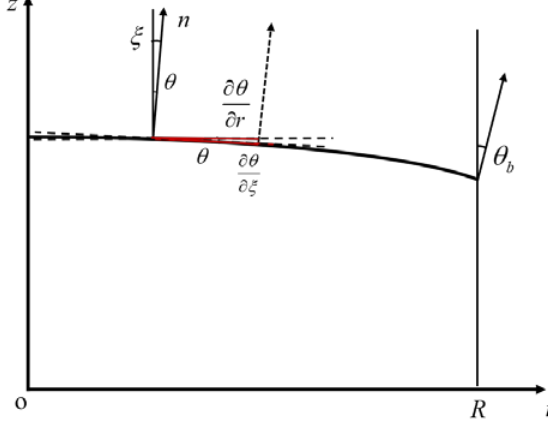
Figure 5. Schematic diagram of detonation wave surface.